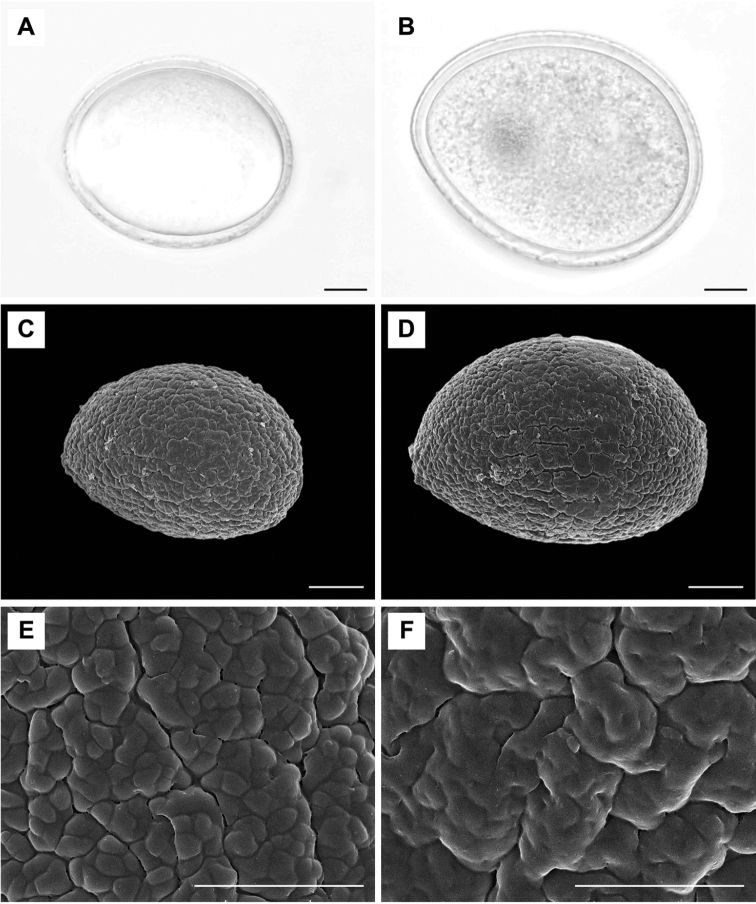
Pollens of G.
godefroyi, G.
harmandii, and Gagnepainia sp. A, B Pollen grains under LMAG.
godefroyi PMNN008 BG.
harmandii PMNN006 C, D Pollen grains under SEMCG.
godefroyi PMNN008 DG.
harmandii PMNN006 E, F Exine sculpturing under SEMEG.
godefroyi PMNN008 FG.
harmandii PMNN006. Scale bar: 10 μm (A–D) and 5 μm (E, F).